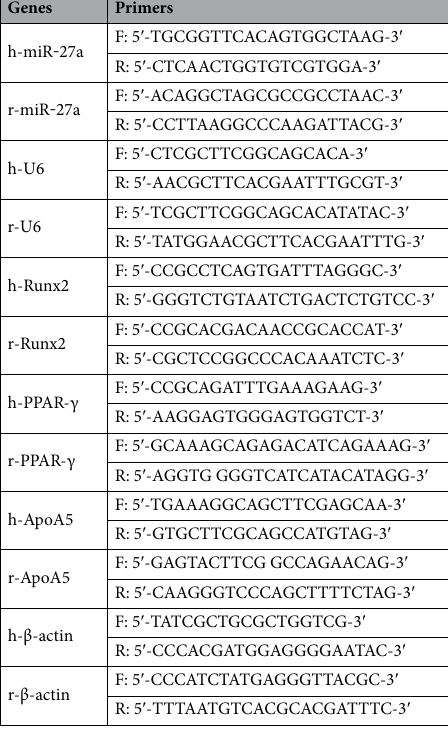
Table 1. Primers used for qRT-PCR. h, human; r,